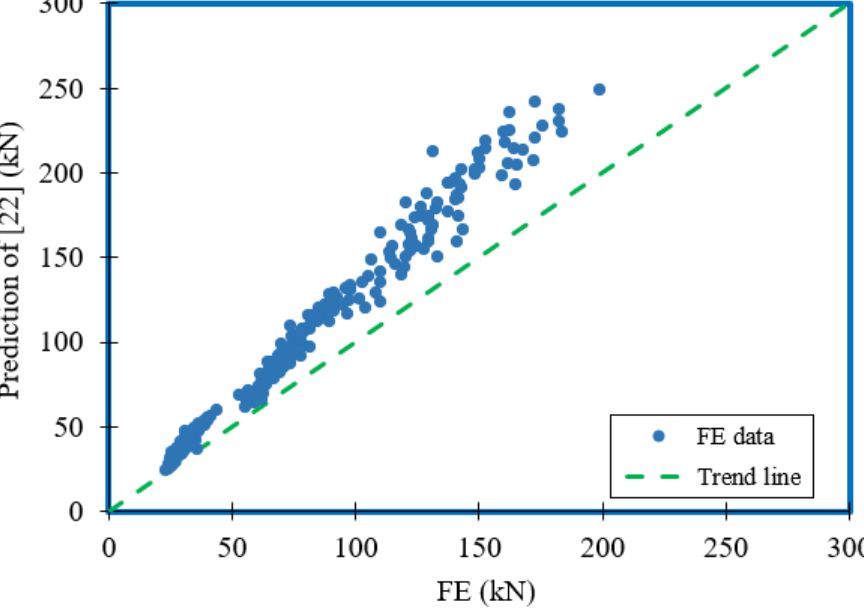
Figure 22. Comparison of parametric results and equation developed by [22].